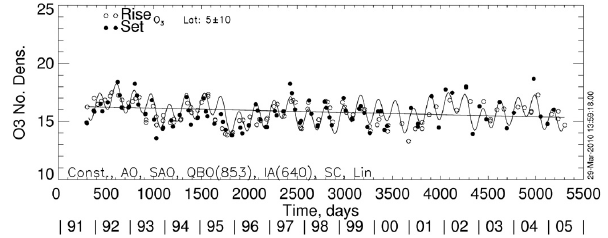
Fig. 5. As in Fig. 2, but for 25 ◦ N and